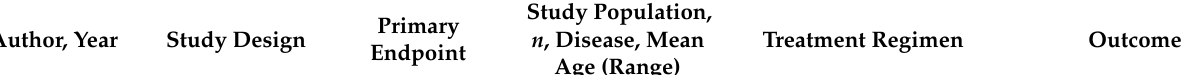
Table 2. Synergistic effect of immunotherapy and metronomic therapy. Clinical